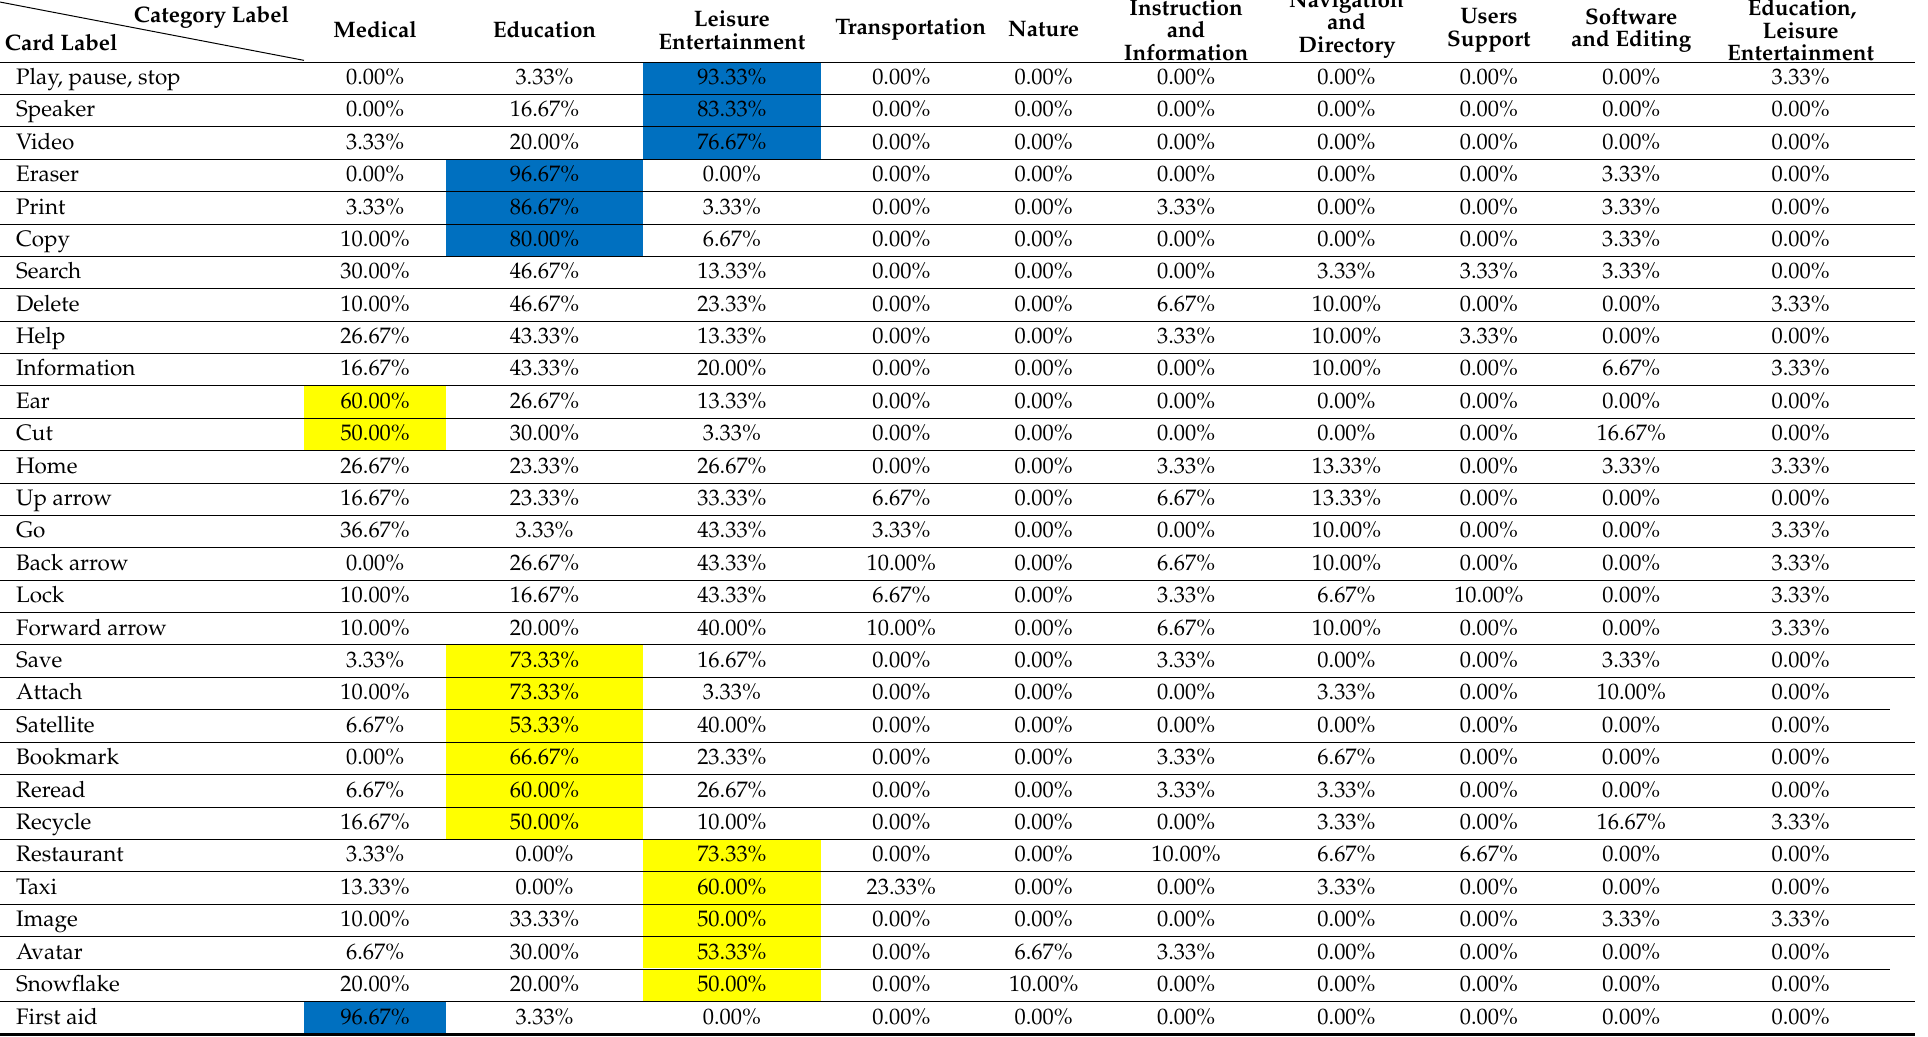
Table A3. Detailed corresponding histogram matrix